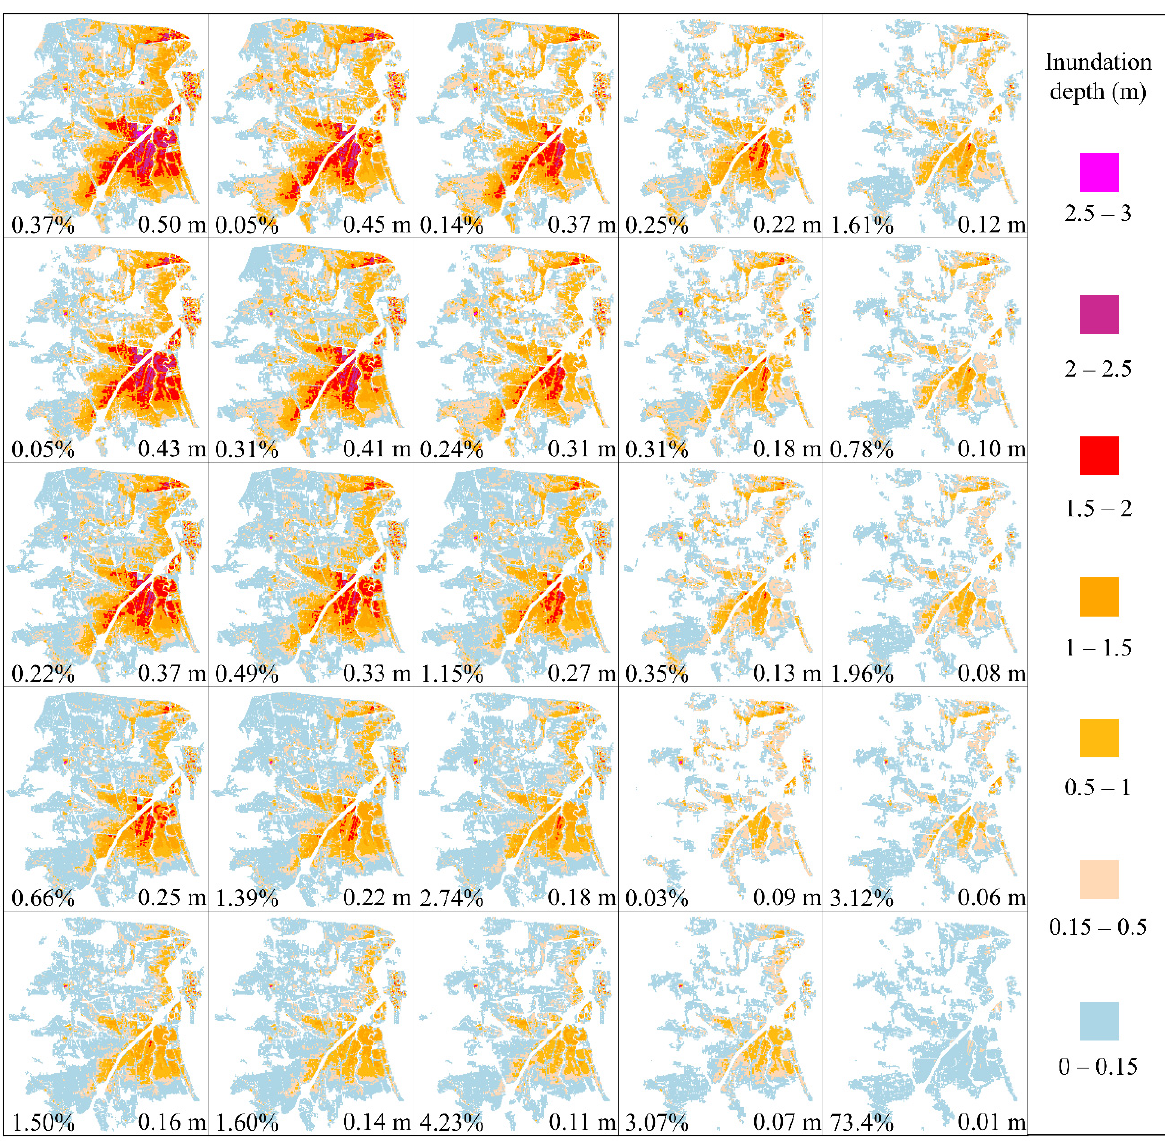
Figure 9. The results of SOM classification.